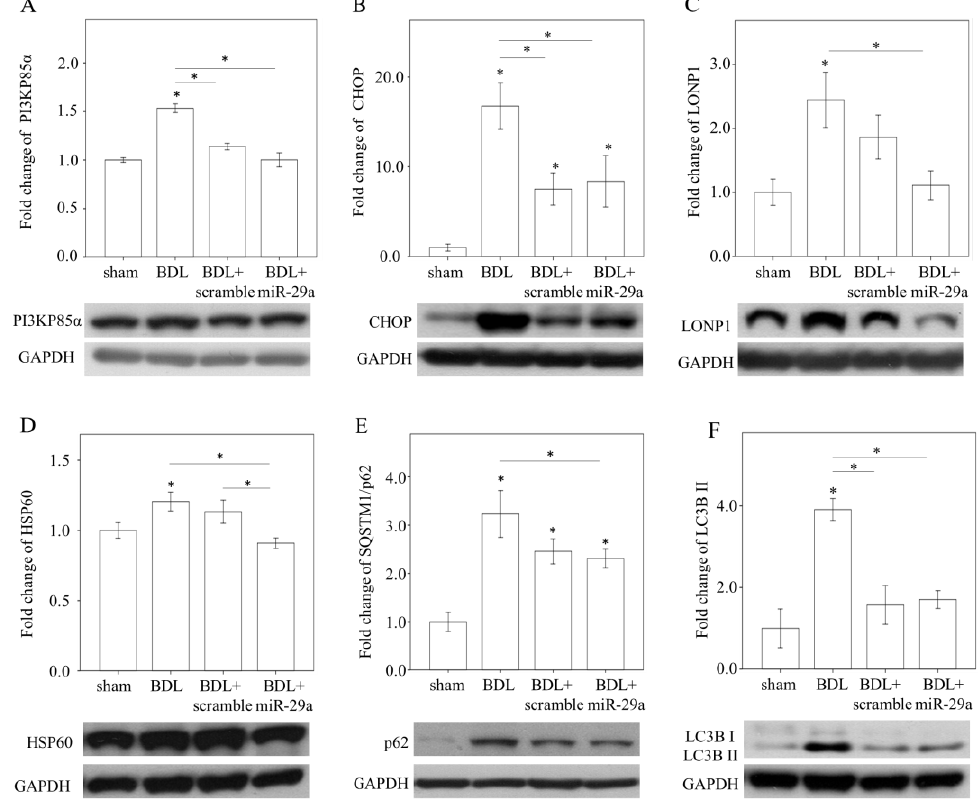
Figure 3. Effect of miR- 29a treatment on protein expression of PI3Kp85α and proteostatic molecules in the liver. Representative image of western blot and densitometric results of PI3Kp85α ( A ), CHOP ( B ), LONP1 ( C ) HSP60 ( D ), SQSTM1/p62 ( E ), and LC3B II ( F ), in mice liver. Data collected from N = 5–6